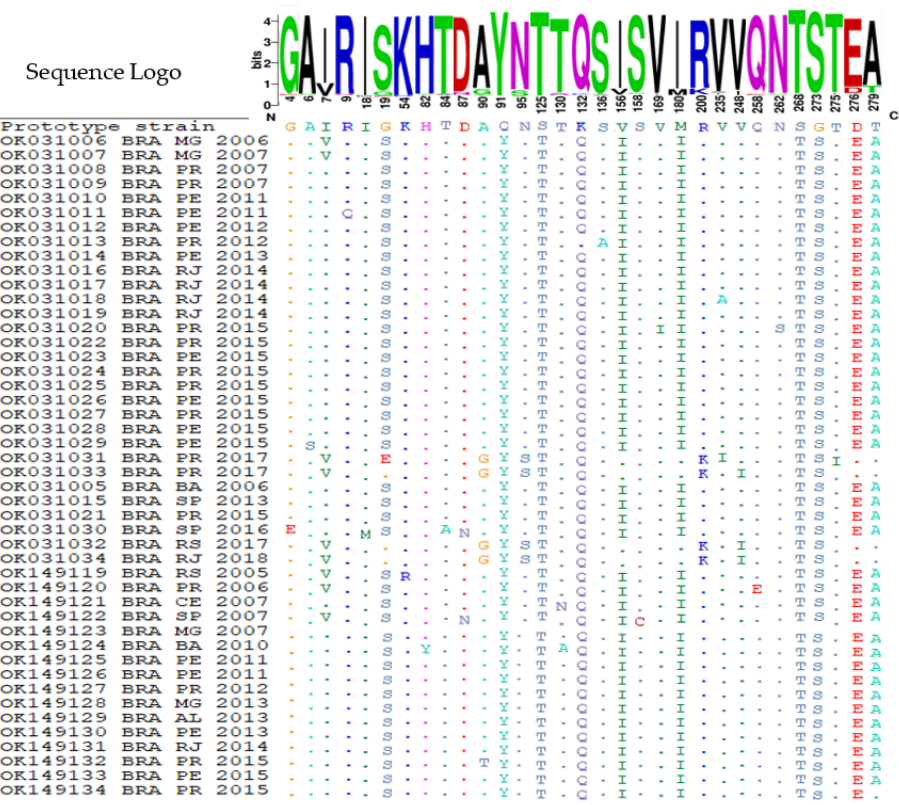
Figure 3. Alignment of deduced amino acid sequences of the VP1 protein from Brazilian CVB5 isolates with the prototype sequence showing variable sites. The dots (.) denote amino acids that are identical to those found in the prototype strain, while the amino acid symbols denote amino acids that are not connected to the prototype. The frequency of aa along the protein is indicated by the letter sequence at the top of the picture. Table 1. Changes and prediction of amino acid substitution impact in the VP1 protein from Brazilian CVB5